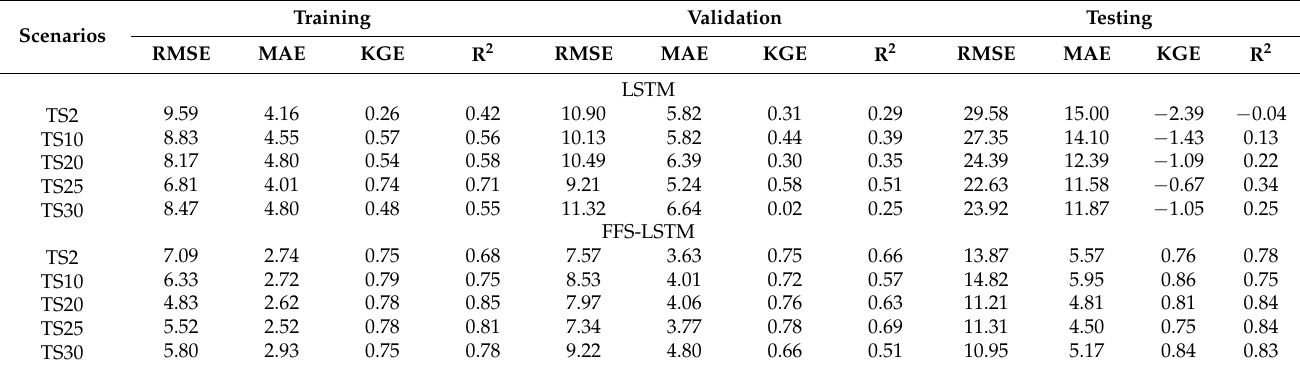
Table 5. Performance of the model scenarios for daily streamflow simulation using approach 2 (considering hydrological year) with a variety of sequence lengths (number of time steps).